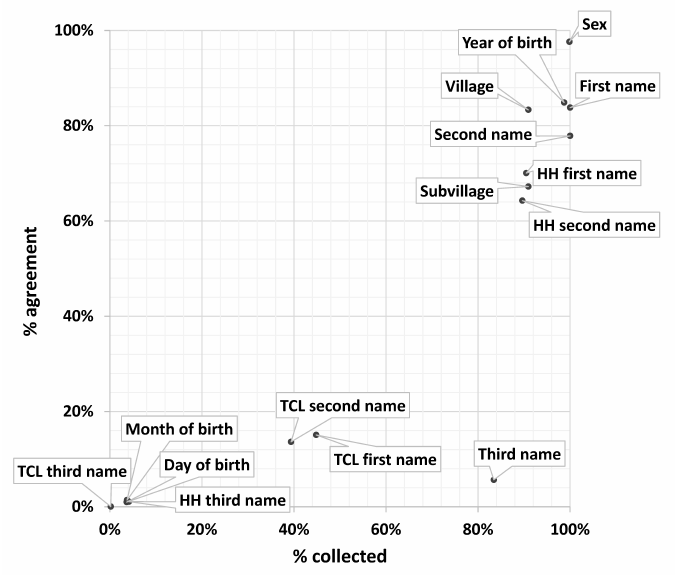
Figure 2: Quality measures of a probabilistic record linkage algorithm used to link health facility and HDSS databases in rural Tanzania, first search attempt